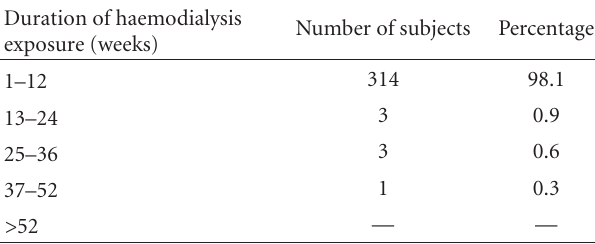
Table 4: Haemodialysis exposure status of subjects.